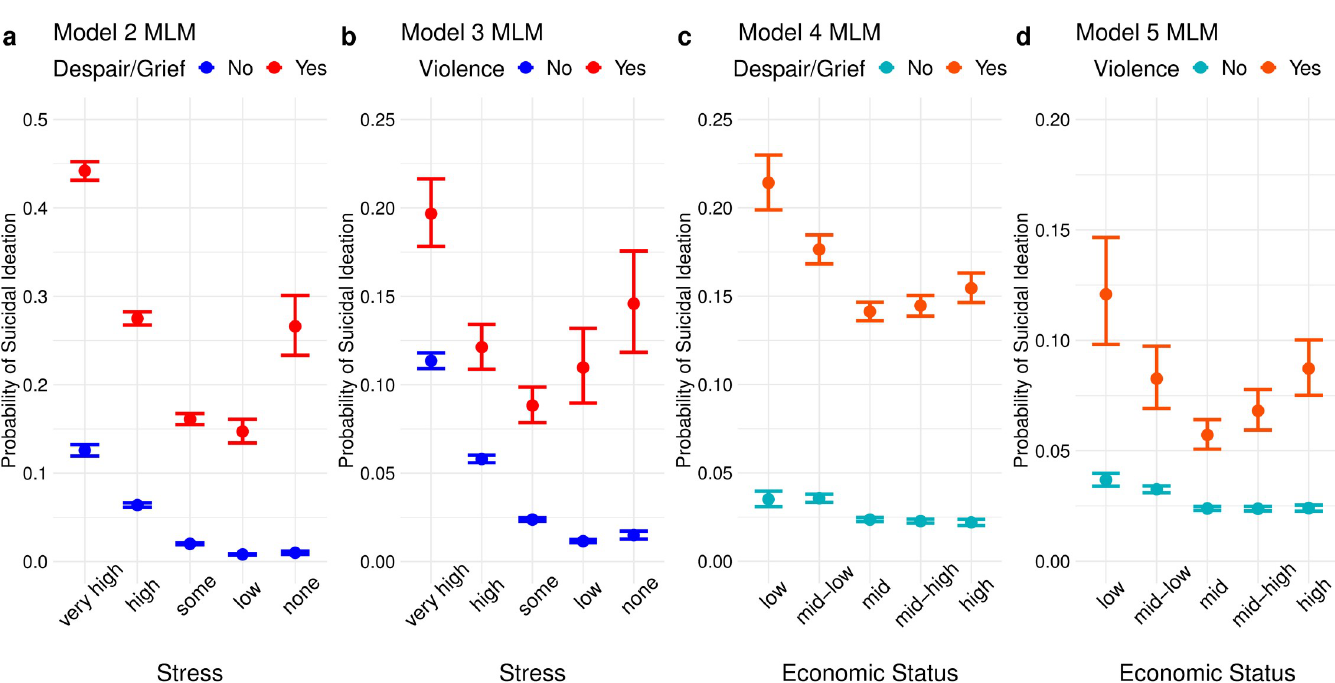
Fig 5. Predicted probability by each category of stress and economic status, multilevel models. All covariates not involved in the interaction terms were set to zero or the reference category. Random effects were set to zero. Error bars indicate 90% credible intervals.